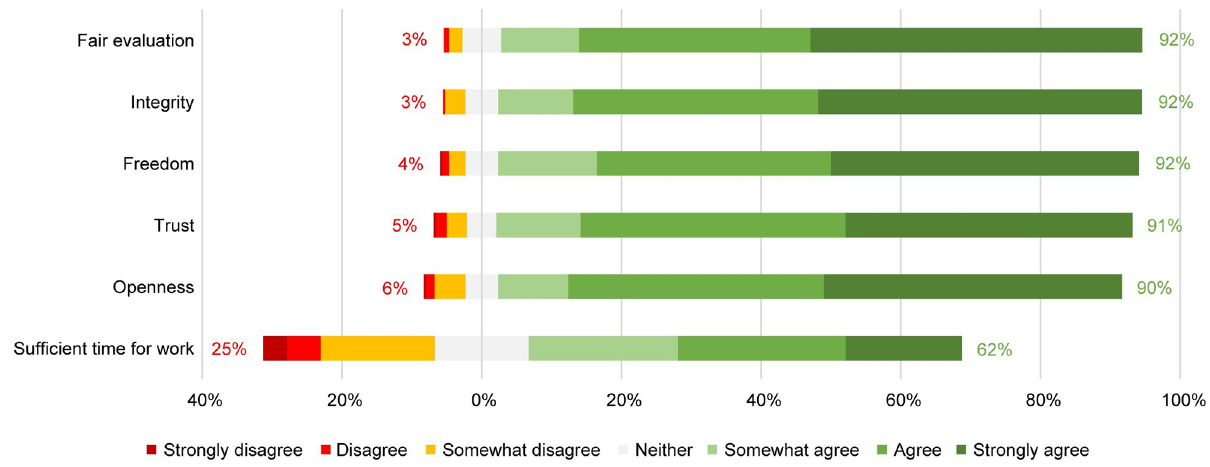
Fig 1. Facilitators of a responsible research climate experienced in the scientific environment.